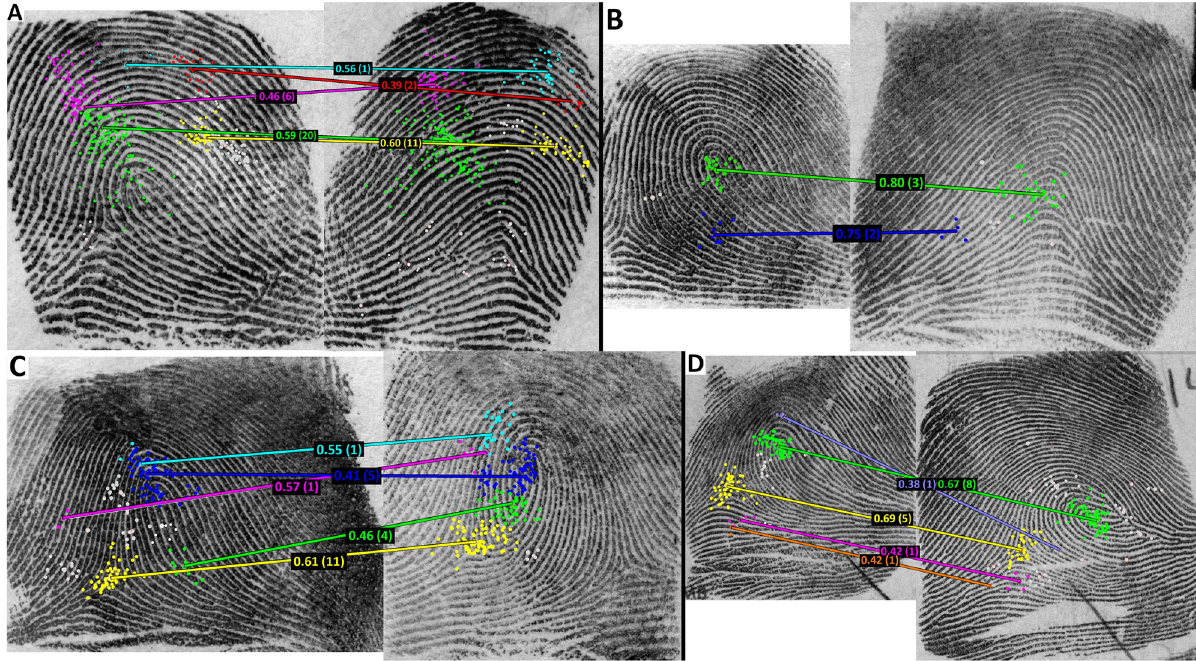
Fig 10. Eye-gaze data from an atypical participant who made four false positive responses on nonmated images that demonstrate high clarity in the latent impression. Each quadrant of the figure is one image pair, and colors are clustered detail fixations. Lines are the estimated correspondence attempts from the TECA model. Proportions represent the strength of the estimated correspondence attempts, and numbers in parentheses are the number of temporal sequences that associated the two linked clusters. Note that in some cases the examiner is ignoring large discrepancies, such as the delta in the right image of panel